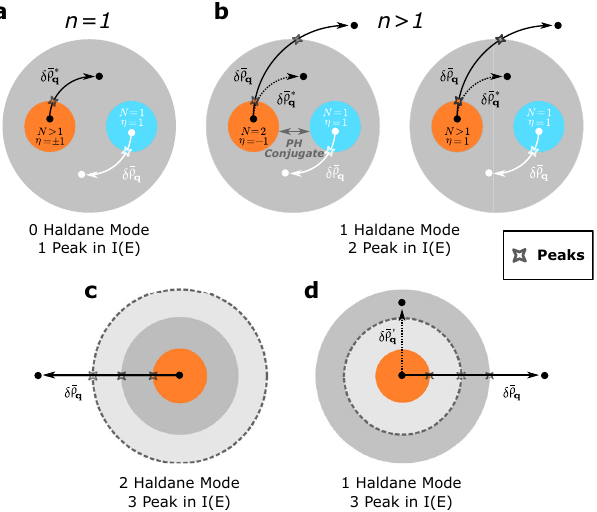
Fig. 7 | Number of Haldane modes for the Jain states at N /(2 nN + η ) with dif- ferent structures of CHSs. a n =1, N >1, η =±1, e.g., the FQH state at 2/3 and 2/5. The white point denotes the Laughlin states ( N =1, η =1) in the corresponding CHS (bluecircle).Because δ (cid:2) ρ q = δ (cid:2) ρ * q ,where δ (cid:2) ρ * q isthedensityoperatorprojectedtothe CHS denoted by the gray circle, these states will show the same behavior as the Laughlin state at 1/3, i.e., one peak with no Haldane mode required. b n >1. In this case, a single Haldane mode is needed in the effective fi eld theory despite two peaks observed in the spectral function, among which, given n , the states with N =2, η = − 1 can be regarded as the particle-hole conjugate partner of the corre- sponding Laughlin state within some speci fi c CHS (gray circle),and the states with N >1, η =1 are the states in higher CF levels as shown in Fig. 2 b . c , d More possible CHSstructures. Thus,the number ofHaldane modesadded to the effective theory cannot be easily reckoned from the number of peaks in the spectral function I ( E ), which is instead related to the microscopic Hamiltonian